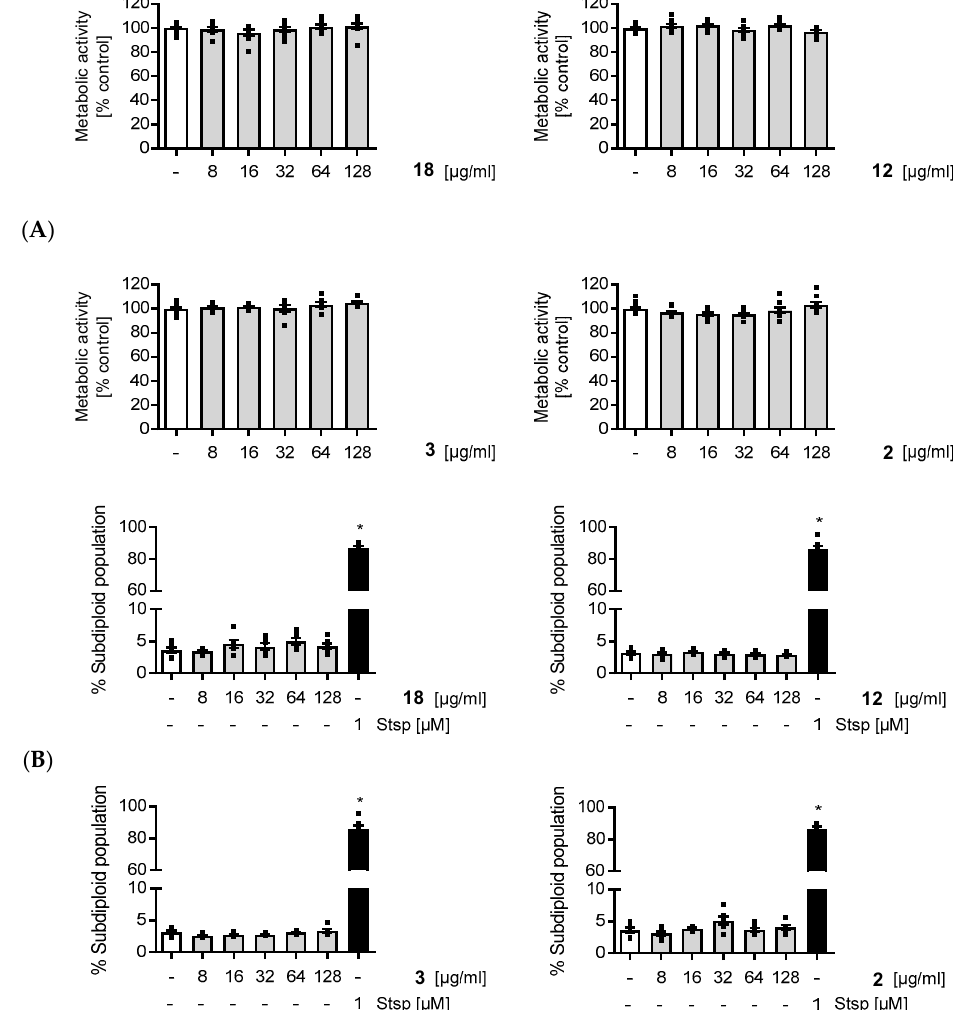
Figure 3. Evaluation of compounds 2 , 3 , 12 , and 18 in cytotoxicity assays. * Staurosporine (Stsp) was used as cytotoxic control.